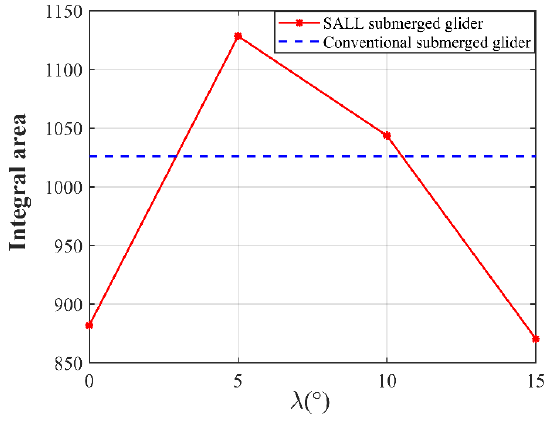
Figure 28. Comparison of integral area under tank experiment.